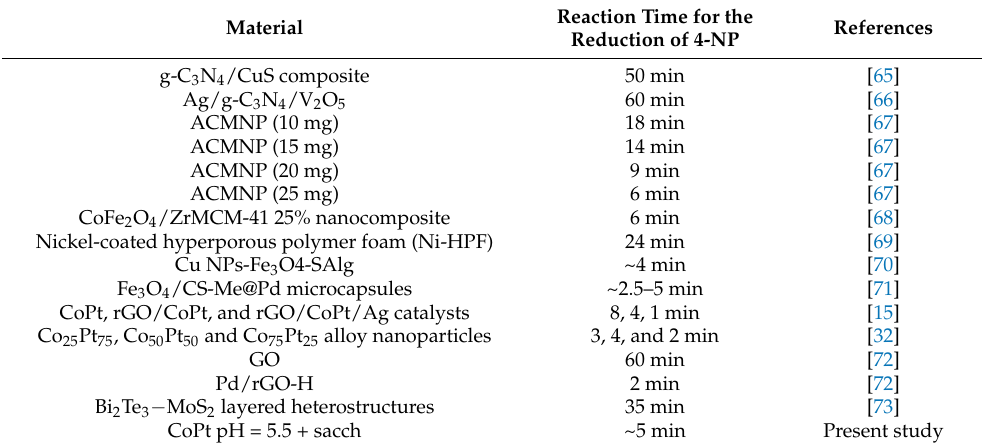
Table 2. Comparison of the catalytic activity with available literature for catalytic reduction of